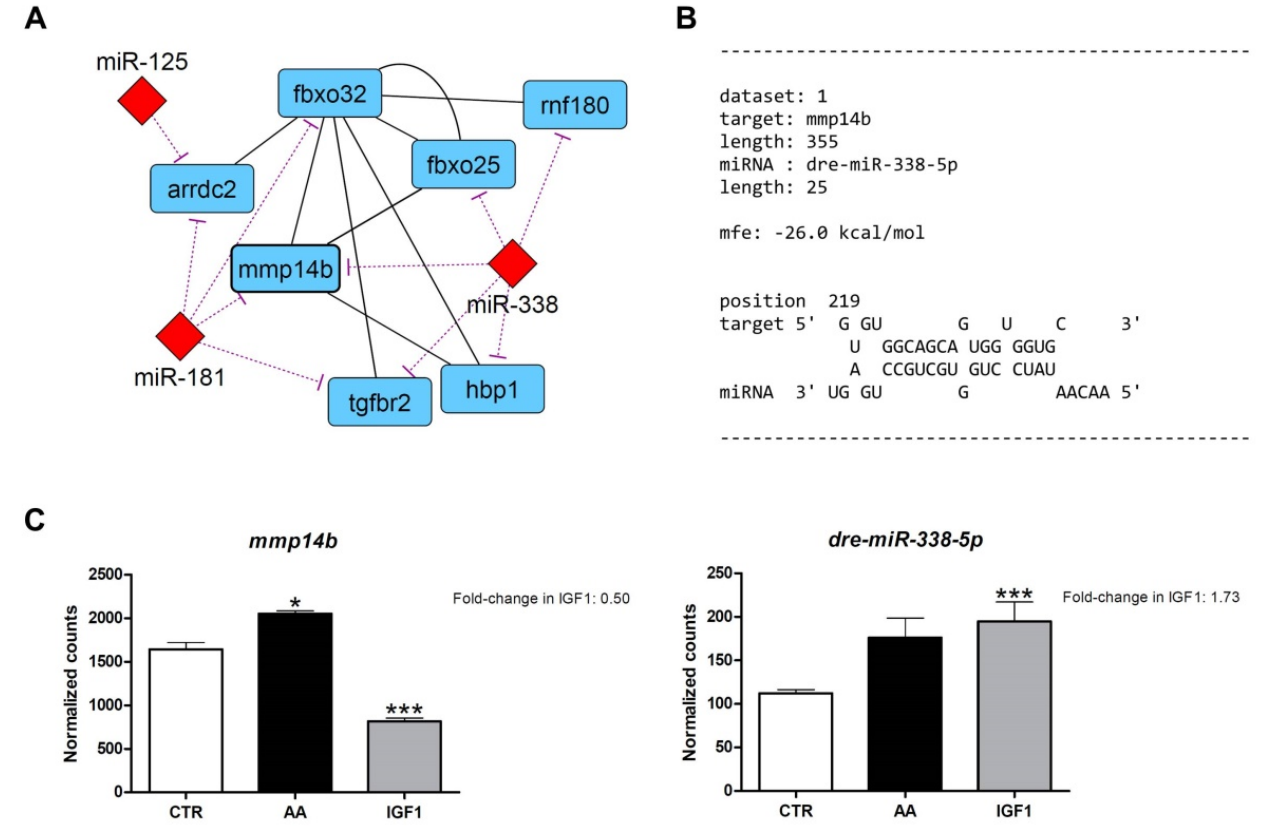
Figure 6. Identification of mmp14b as potential target of miR-338-5p in IGF1 pacu-cultured myotubes. ( A ) Interaction molecular network between mmp14b ( matrix metallopeptidase 14b ), miR-338 and other differentially expressed genes and miRNAs. Down-regulated genes are represented by light blue color, and up-regulated miRNAs are represented by red color. Purple lines show interaction between miRNAs and genes, and black lines show interaction between the genes. ( B ) Bioinformatics prediction of the mmp14b / miR-338-5p hybridization. The MFE (minimum free energy) value was within accepted range. ( C ) Gene expression of mmp14b and dre-miR-338-5p in CTR, AA and IGF1 groups according to the differential expression analyses. Expression is shown as number of counts, and values represent means ± s.e.m. ( n = 3 independent cell cultures). The fold-changes in IGF1 group are shown in the graphs, and asterisks indicate significant differences between groups: *: p - adj < 0.05; ***: p -adj < 0.001.